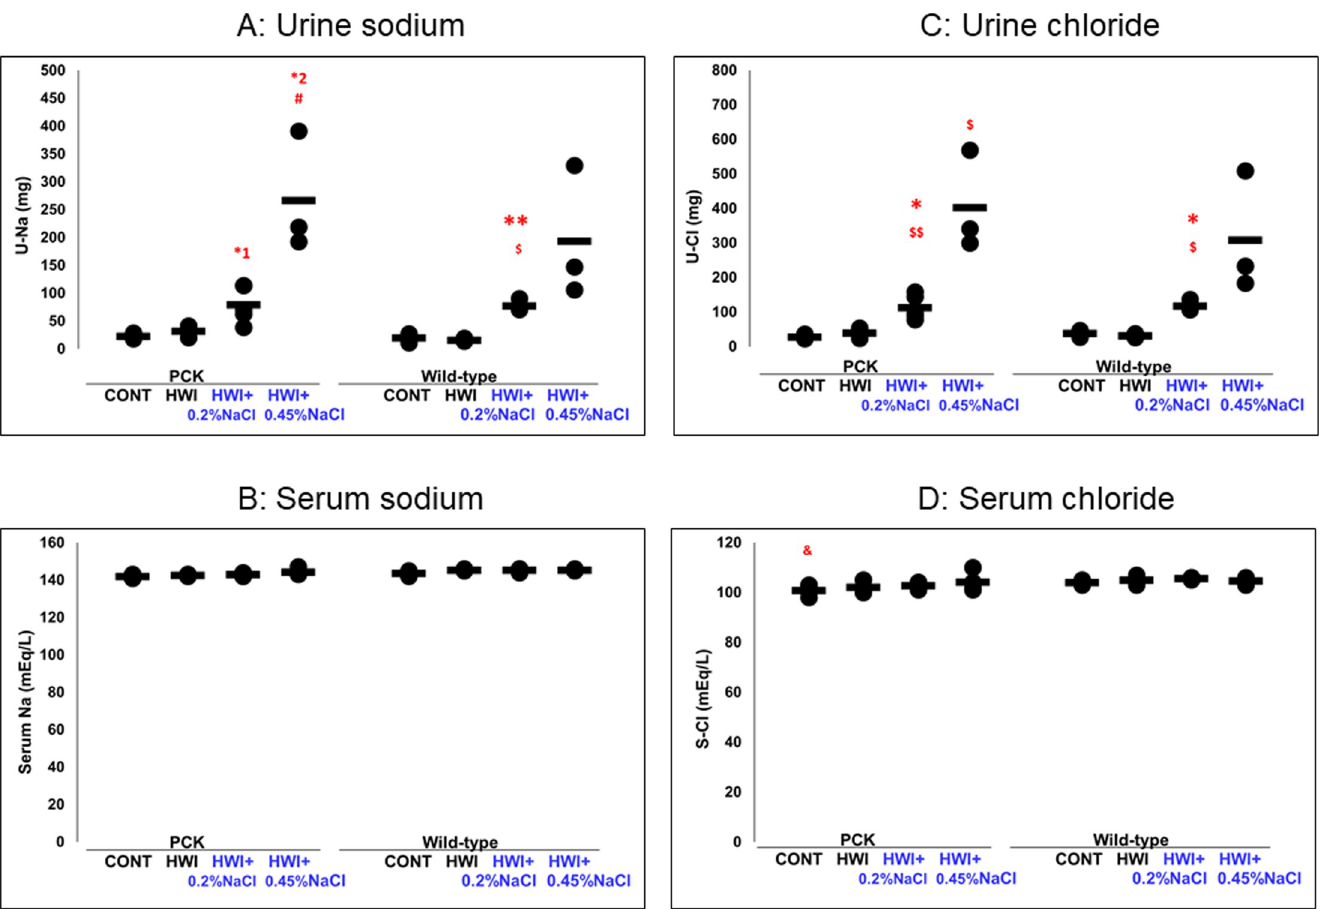
Fig 5. Effects of HWI and salt intake on urine excretion and serum concentrations of NaCl. CONT, distilled water group; HWI, high water intake group (5% glucose); HWI+0.2%NaCl, high water intake with 0.2% NaCl group; HWI+0.45%NaCl, high water intake with 0.45% NaCl group. Difference between PCK CONT and wild-type CONT groups: &, P < 0.05. Comparison between CONT and treated groups: � 1, P = 0.053; � 2, P = 0.059; � , P < 0.05; �� , P < 0.01. Comparison between HWI and HWI+0.2%NaCl or HWI+0.45%NaCl: $, P < 0.05; $$, P < 0.01. Comparison between HWI+0.2%NaCl and HWI+0.45%NaCl: #, P < 0.05.